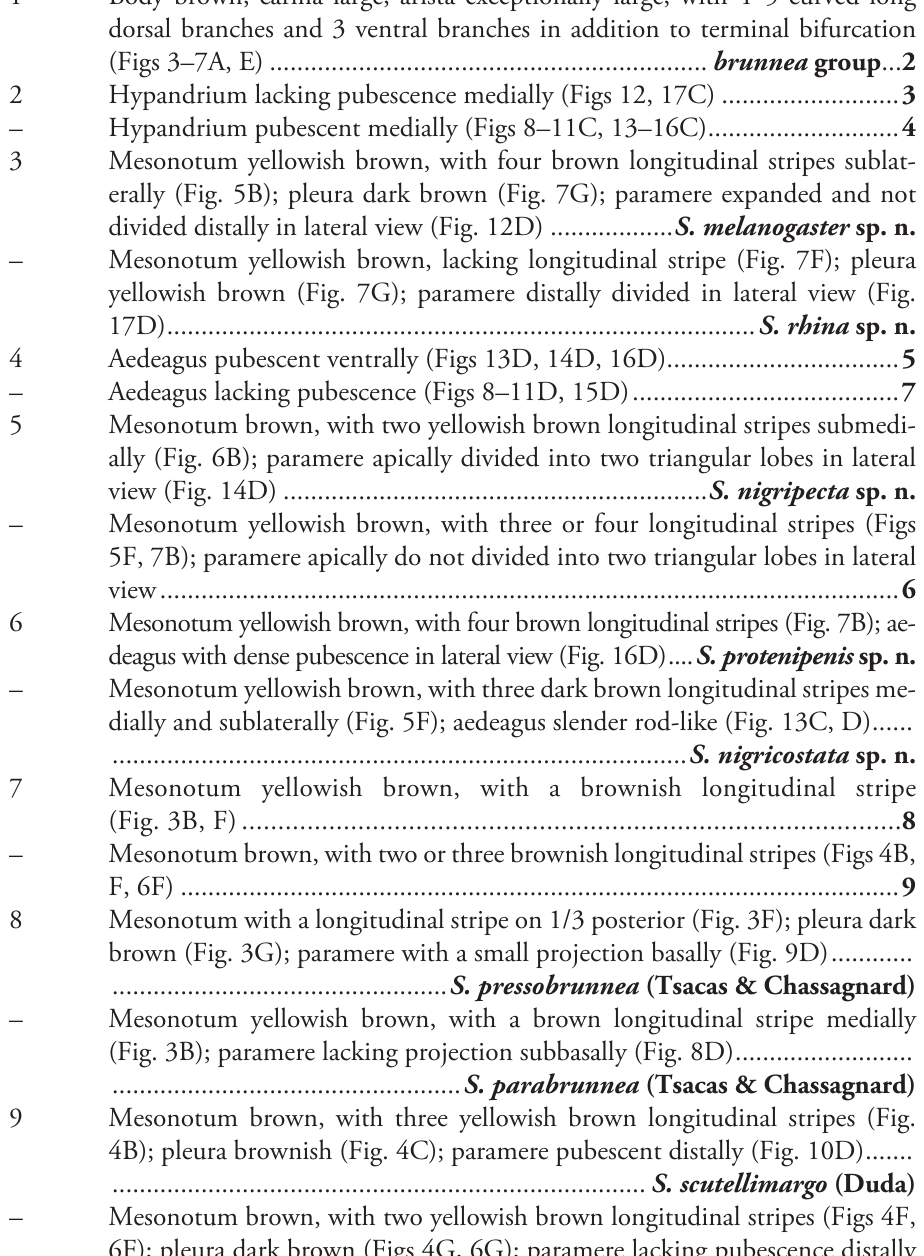
Key to examined species of the brunnea group 1 Body brown; carina large; arista exceptionally large, with 4–5 curved long dorsal branches and 3 ventral branches in addition to terminal bifurcation (Figs 3–7A, E) ................................................................ brunnea group ... 2 2 Hypandrium lacking pubescence medially (Figs 12, 17C) .......................... 3 – Hypandrium pubescent medially (Figs 8–11C, 13–16C) ............................ 4 3 Mesonotum yellowish brown, with four brown longitudinal stripes sublat- erally (Fig. 5B); pleura dark brown (Fig. 7G); paramere expanded and not divided distally in lateral view (Fig. 12D) .................. S. melanogaster sp. n. Mesonotum yellowish brown, lacking longitudinal stripe (Fig. 7F); pleura yellowish brown (Fig. 7G); paramere distally divided in lateral view (Fig. 4 Aedeagus pubescent ventrally (Figs 13D, 14D, 16D).................................. 5 Aedeagus lacking pubescence (Figs 8–11D, 15D) ....................................... 7 5 Mesonotum brown, with two yellowish brown longitudinal stripes submedi- ally (Fig. 6B); paramere apically divided into two triangular lobes in lateral view (Fig. 14D) .............................................................. S. nigripecta sp. n. – Mesonotum yellowish brown, with three or four longitudinal stripes (Figs 5F, 7B); paramere apically do not divided into two triangular lobes in lateral 6 Mesonotum yellowish brown, with four brown longitudinal stripes (Fig. 7B); ae- deagus with dense pubescence in lateral view (Fig. 16D) .... S. protenipenis sp. n. – Mesonotum yellowish brown, with three dark brown longitudinal stripes me- dially and sublaterally (Fig. 5F); aedeagus slender rod-like (Fig. 13C, D) ...... 7 Mesonotum yellowish brown, with a brownish longitudinal stripe (Fig. 3B, F) ........................................................................................... 8 – Mesonotum brown, with two or three brownish longitudinal stripes (Figs 4B, F, 6F) ......................................................................................................... 9 8 Mesonotum with a longitudinal stripe on 1/3 posterior (Fig. 3F); pleura dark brown (Fig. 3G); paramere with a small projection basally (Fig. 9D) ............ – Mesonotum yellowish brown, with a brown longitudinal stripe medially (Fig. 3B); paramere lacking projection subbasally (Fig. 8D) .......................... 9 Mesonotum brown, with three yellowish brown longitudinal stripes (Fig. 4B); pleura brownish (Fig. 4C); paramere pubescent distally (Fig. 10D) ....... – Mesonotum brown, with two yellowish brown longitudinal stripes (Figs 4F, 6F); pleura dark brown (Figs 4G, 6G); paramere lacking pubescence distally (Figs 11C, D, 15C, D) .............................................................................